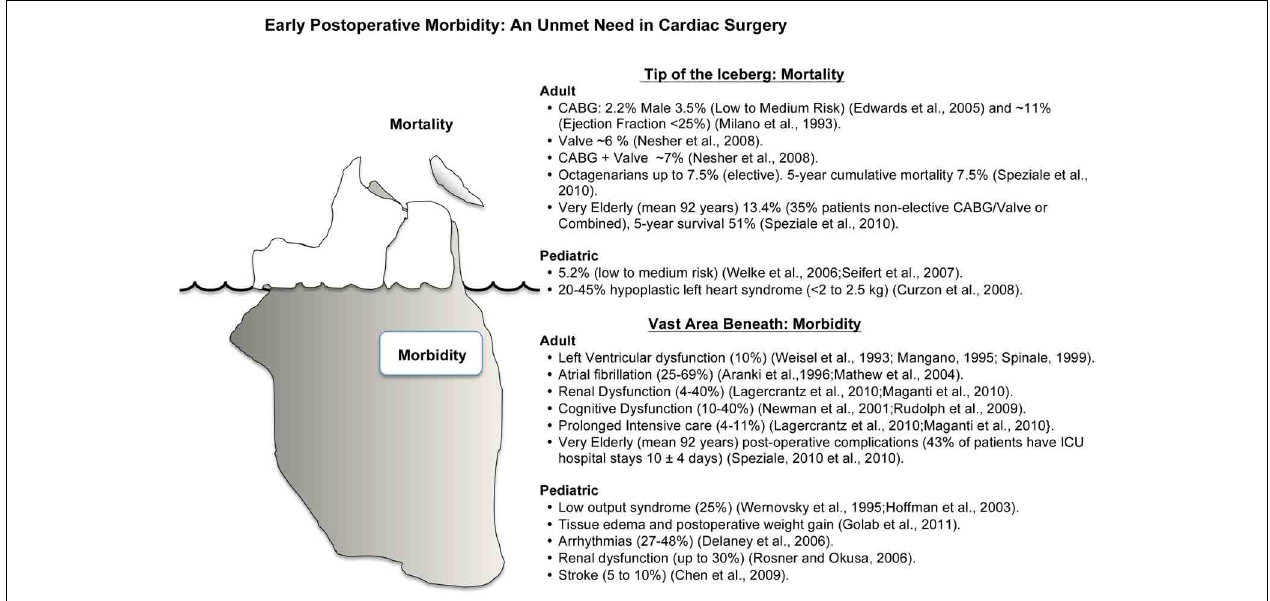
FIGURE 1 | Schematic representation of mortality and morbidity in cardiac surgery. Mortality and morbidity have many interacting and confounding factors with ischemia-reperfusion injury playing a